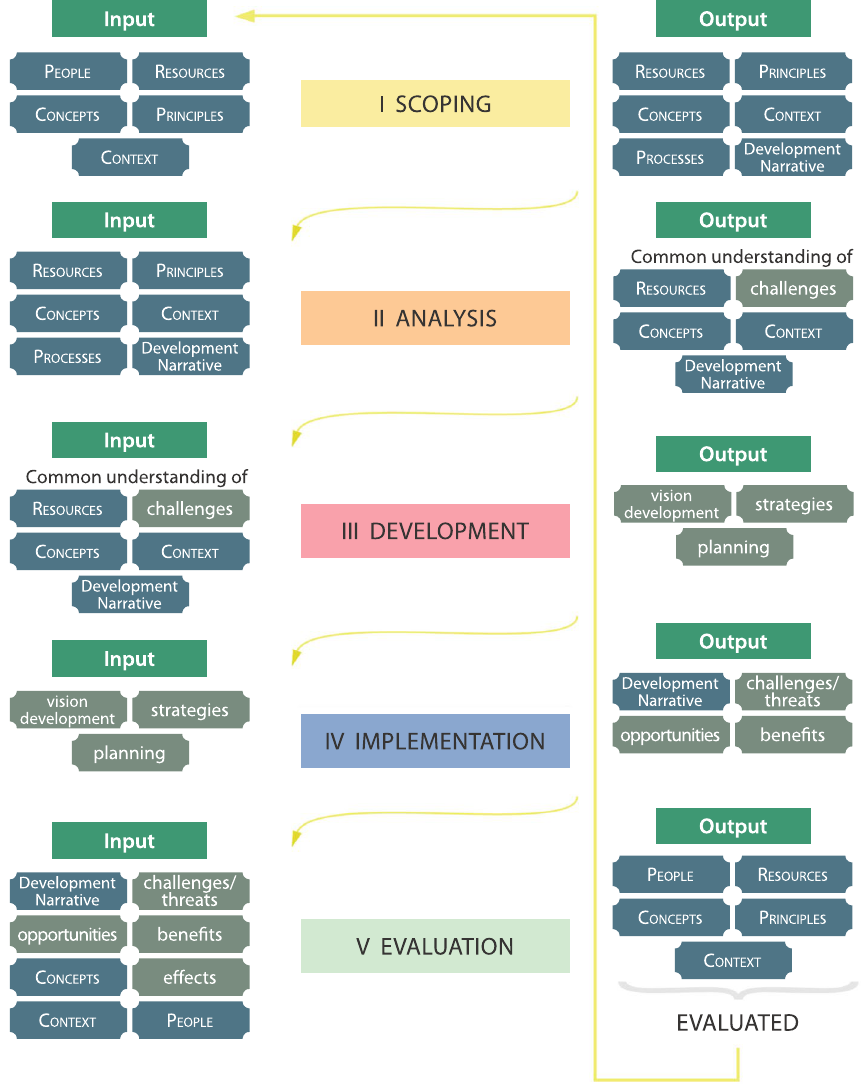
Fig. 6 Logic connections between the five phases of heritage-based urban development (Source: Ripp